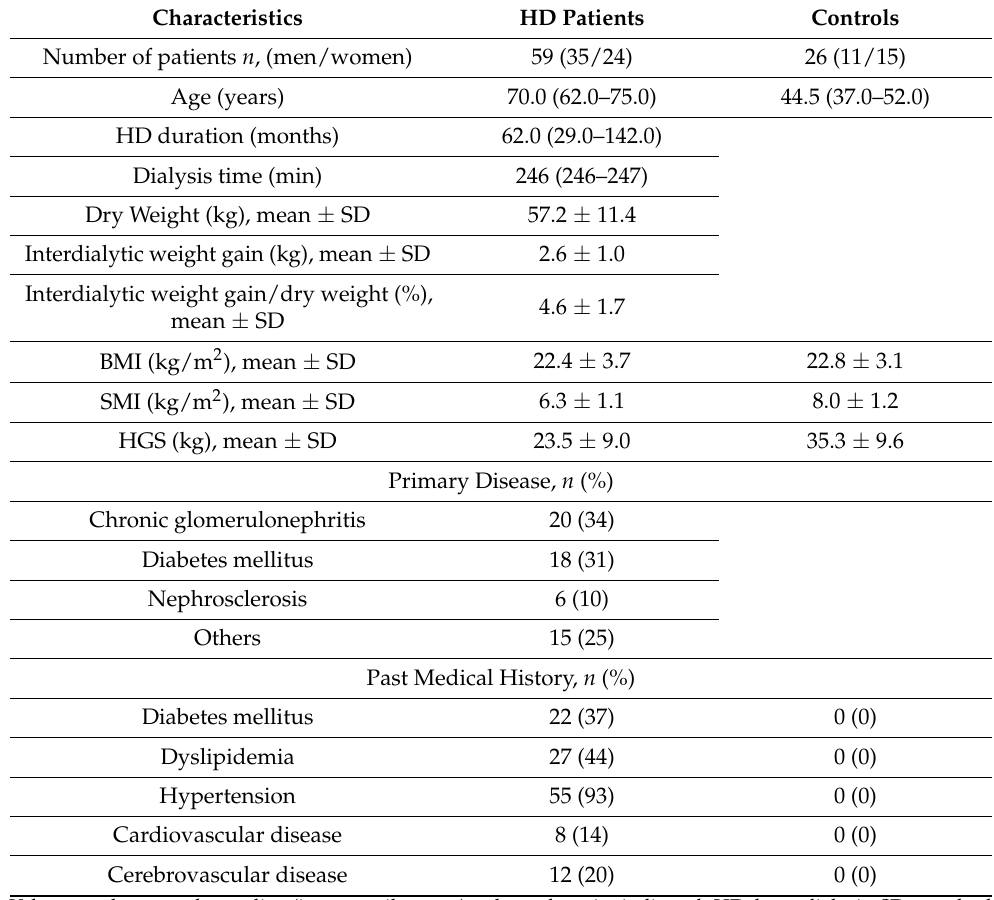
Table 1. Characteristics of study